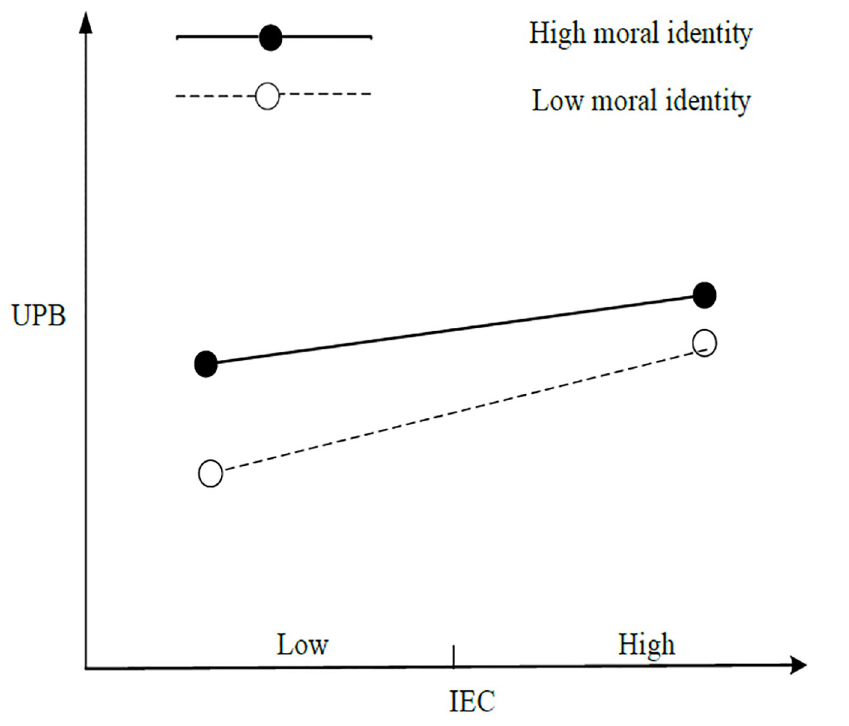
Fig 2. Simple slope test for